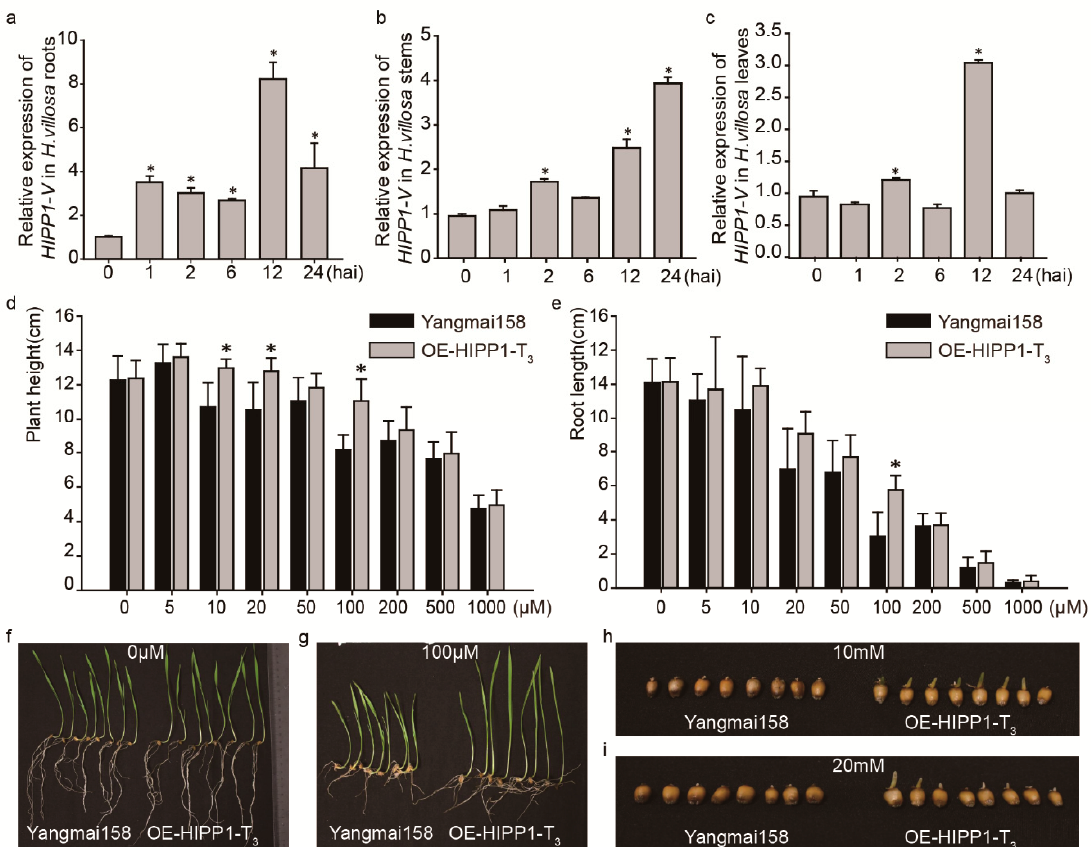
Figure 6. Tolerance of HIPP1-V transgenic plants to Cd. Time-course expression profiling of HIPP1-V of H . villosa in response to Cd treatment in the roots ( a ), stems ( b ), and leaves ( c ). ( d ) The plant height between OE-HIPP1-T 3 and Yangmai158 plants exposed to di ff erent Cd concentrations. ( e ) The root length between OE-HIPP1-T 3 and Yangmai158 plants in di ff erent Cd concentrations. ( f – i ) OE-HIPP1-T 3 and Yangmai158 phenotypes under treatments of di ff erent Cd concentrations (0, 100 µ M, 10 mM, and 20 mM). * p < 0.05. hai: hours after induction.